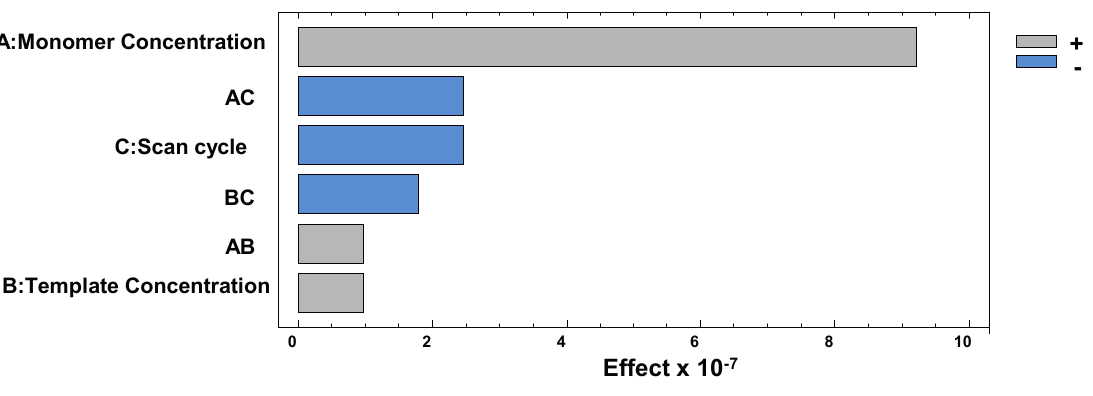
Figure 2. Pareto chart obtained in the optimisation of the electropolymerisation process.